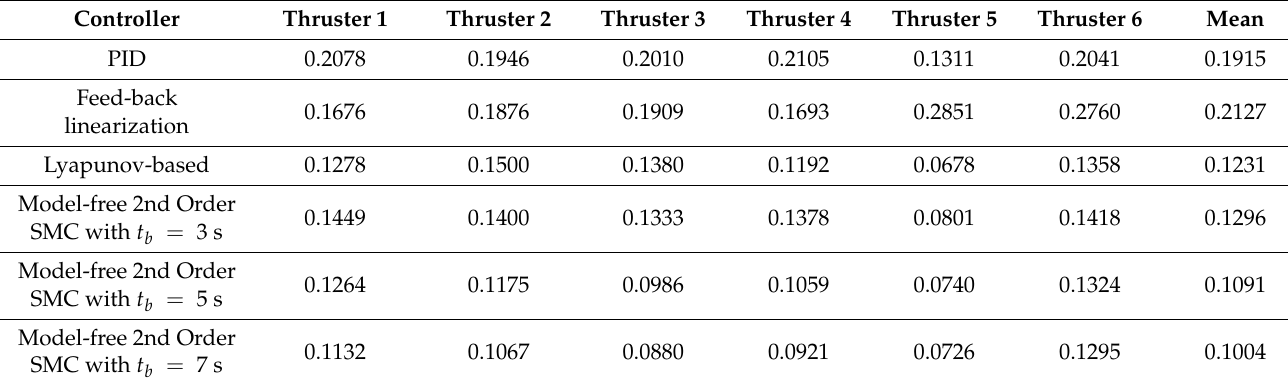
Table 5. Root Mean Square (RMS) values for thrusters control coefficients.